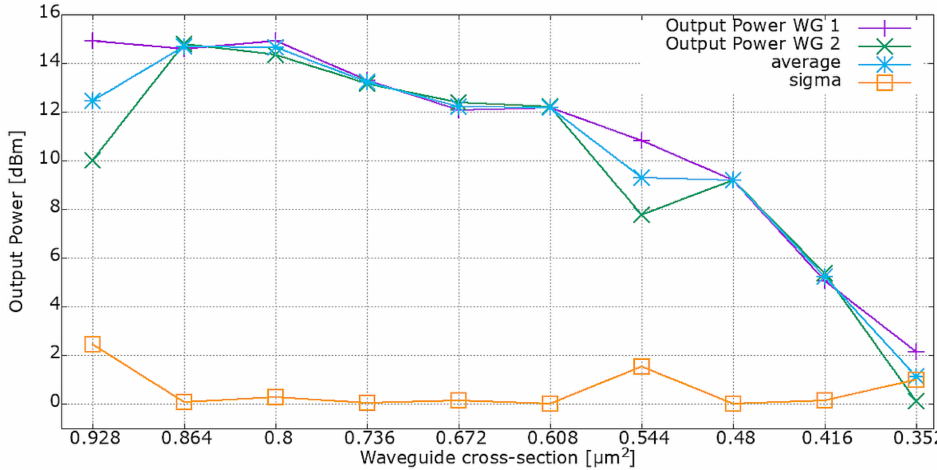
Figure 19. Output power correlation with WG’s cross-sections.